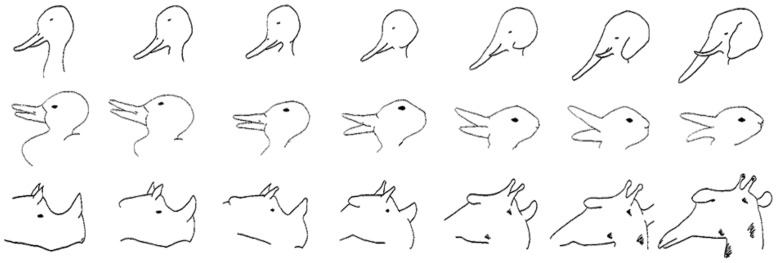
Bistable image examples (rabbit-duck, rhino-giraffe, and duck-elephant; originally from Hogeboom (1995), as cited in Verstijnen and Wagemans (2004).